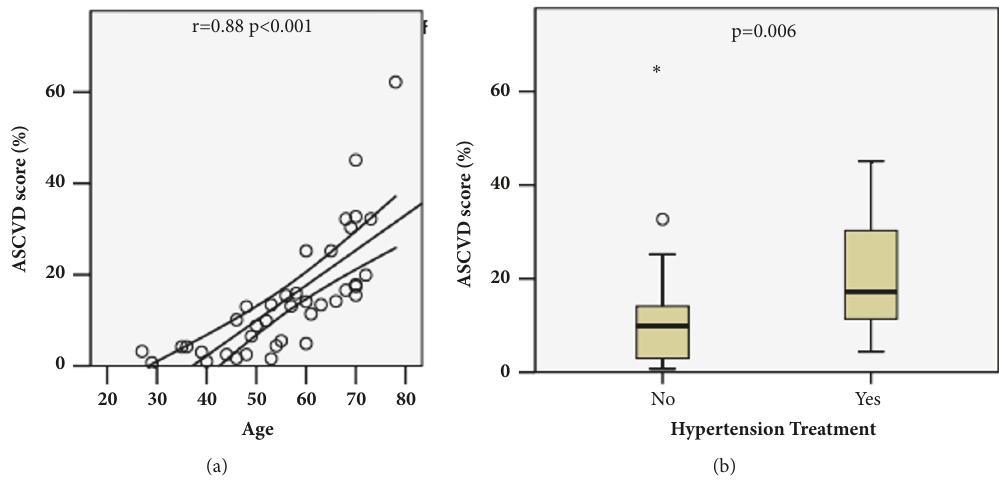
Figure 1: Age and hypertension treatment status scoring components are associated with ASCVD 10-year risk score. (a) Age (years) versus ASCVD 10-year risk score (%). Spearman’s r and p values shown, along with linear trend line and 95% confidence intervals. (b) Box plot of hypertension treatment status versus ASCVD 10-year risk score (%). The p value was calculated by the Mann-Whitney U test.